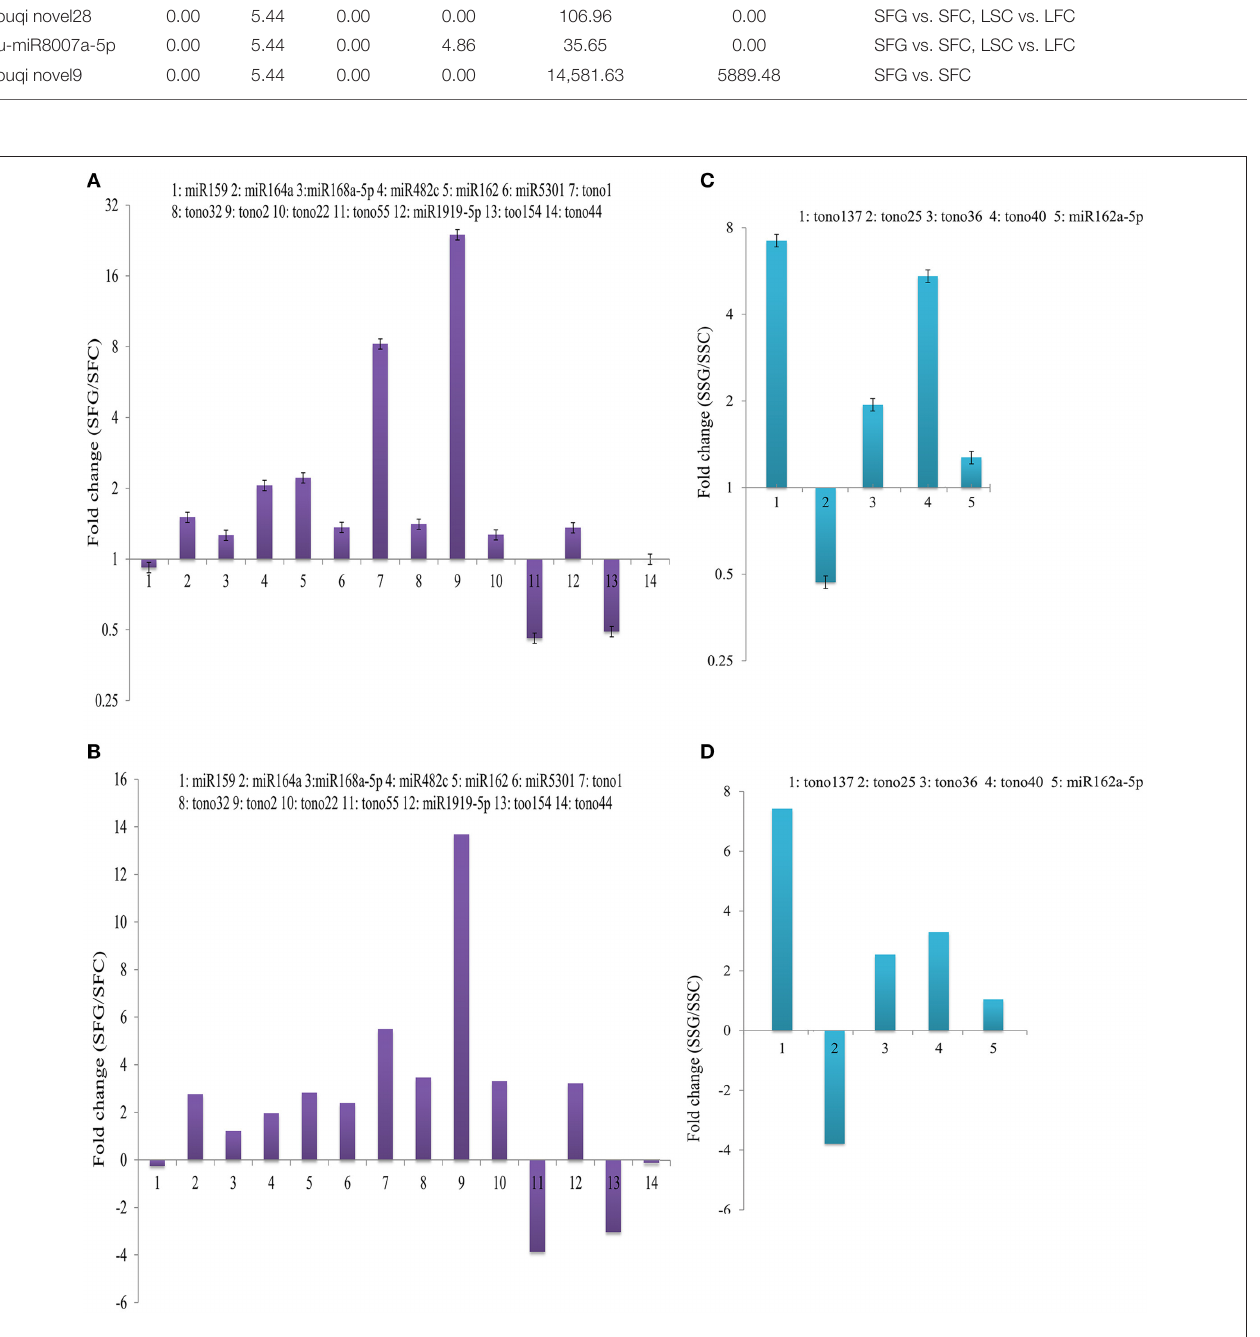
FIGURE 8 | Expression ratios (grafted fruit/control fruit) of miRNAs in (A) qRT-PCR and (B) sequencing results; and (grafted shoot/control shoot) ratios in (C) qRT-PCR and (D) sequencing results. X-axis, name of the miRNAs that were selected for qRT-PCR; column above the X-axis, miRNAs that were up-regulated in the grafted fruit and shoot; column below the X-axis, miRNAs that were up-regulated in the grafted and control shoot.